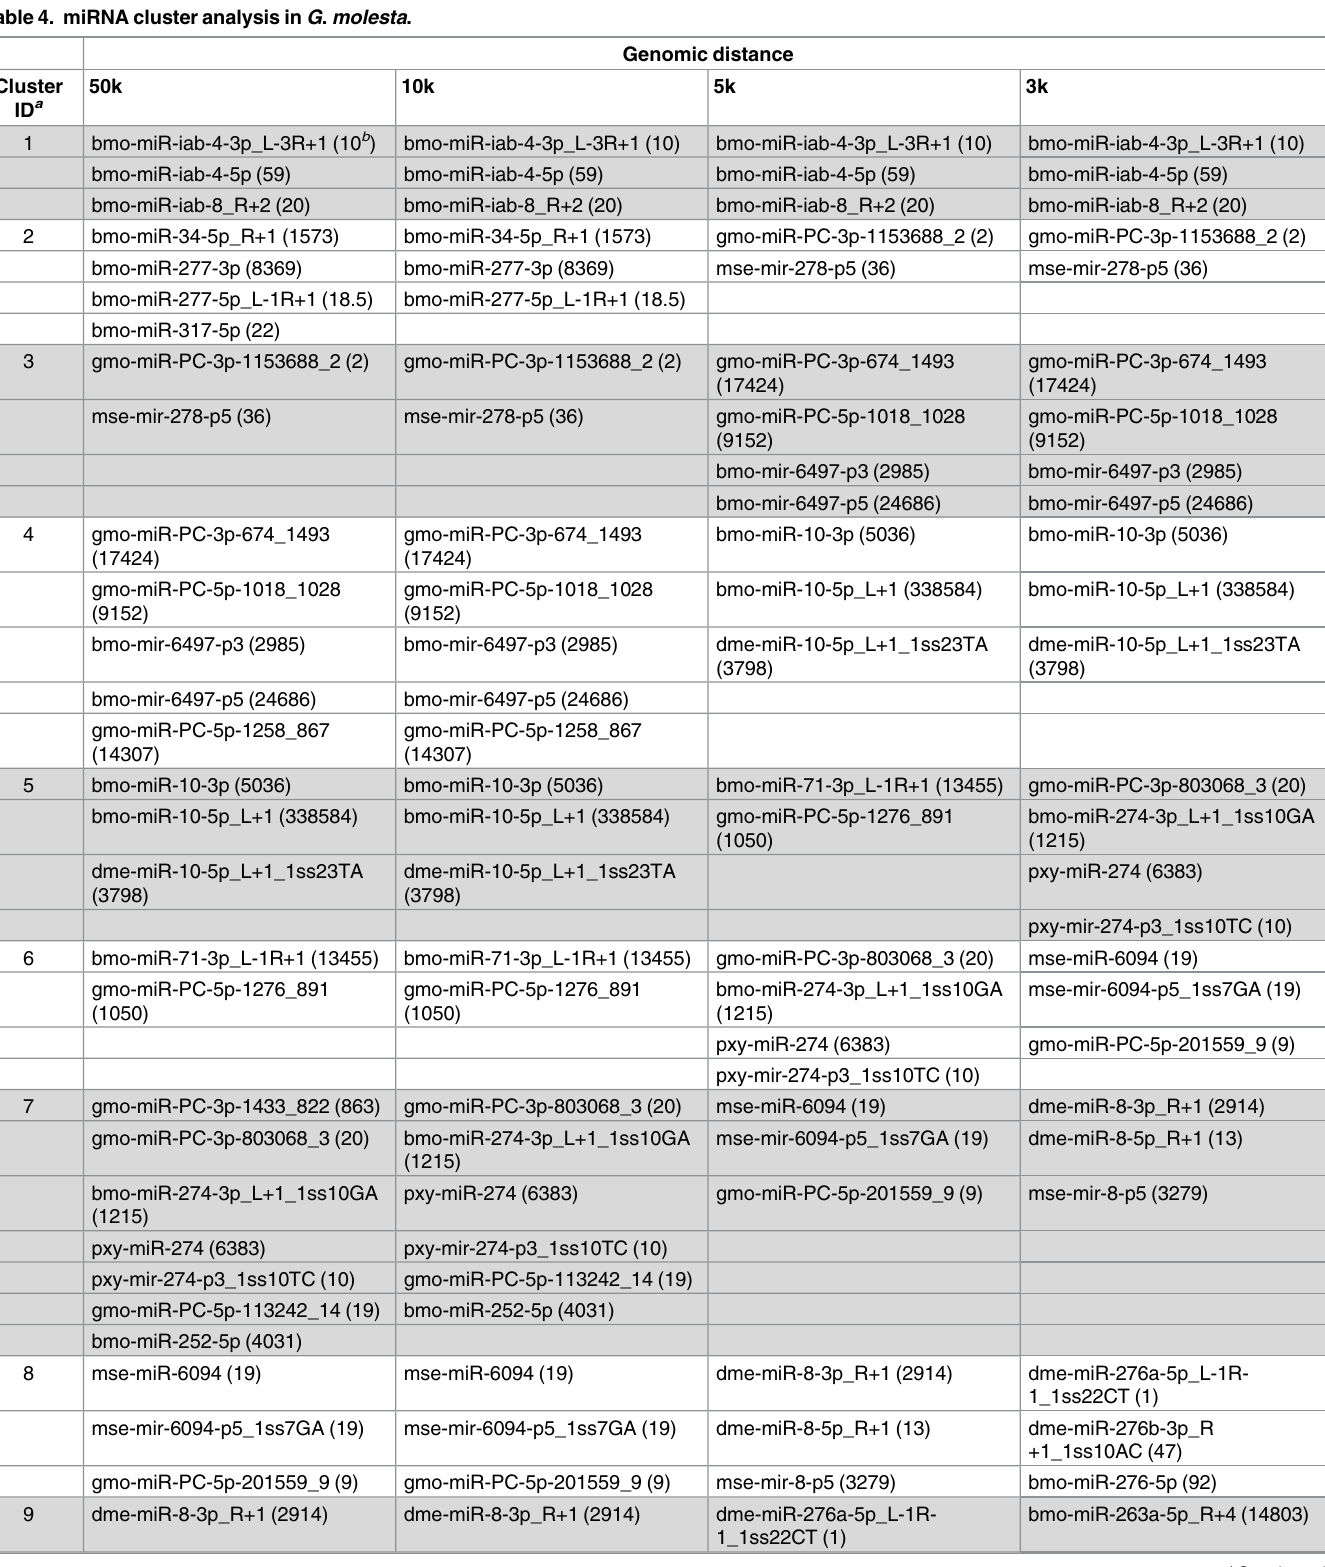
Table 4. miRNA cluster analysis in G . molesta .